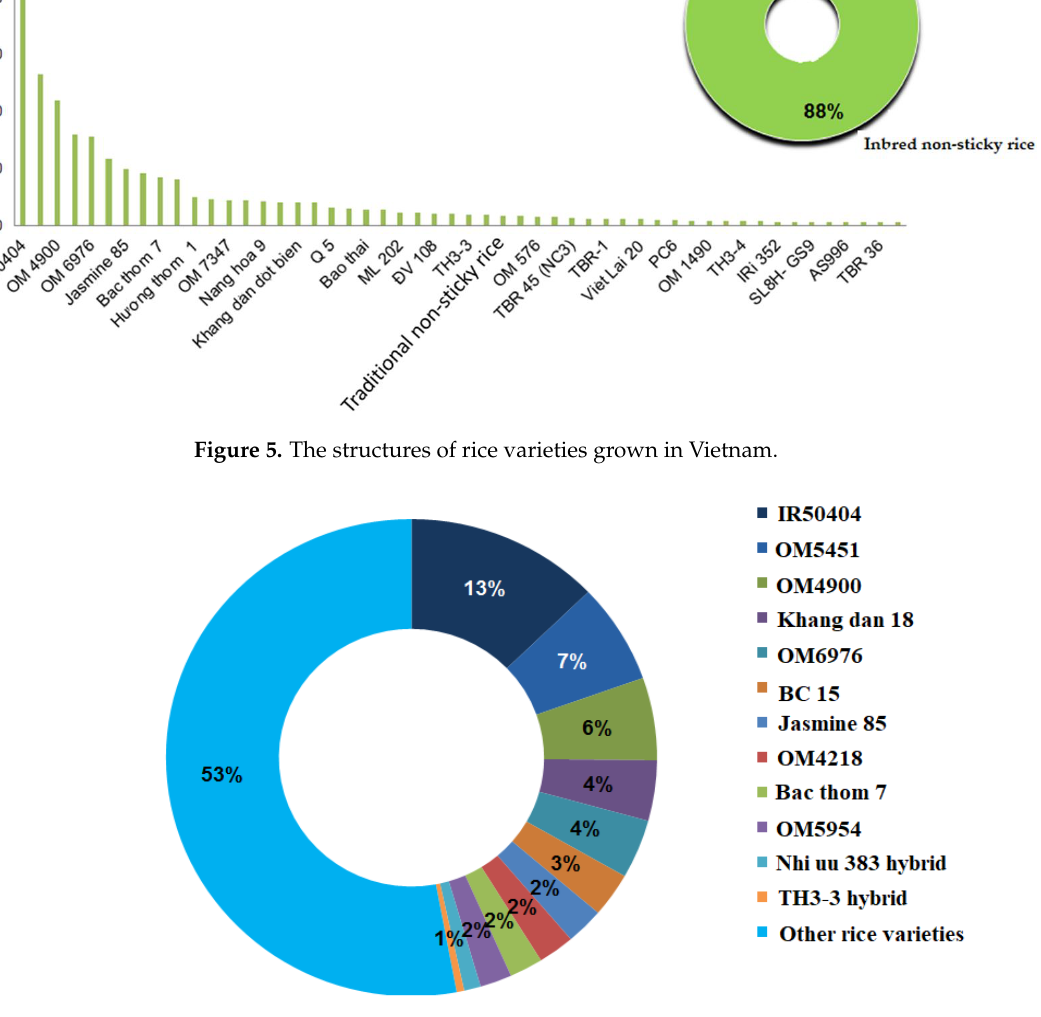
Figure 6. Major rice varieties are grown in Vietnam.